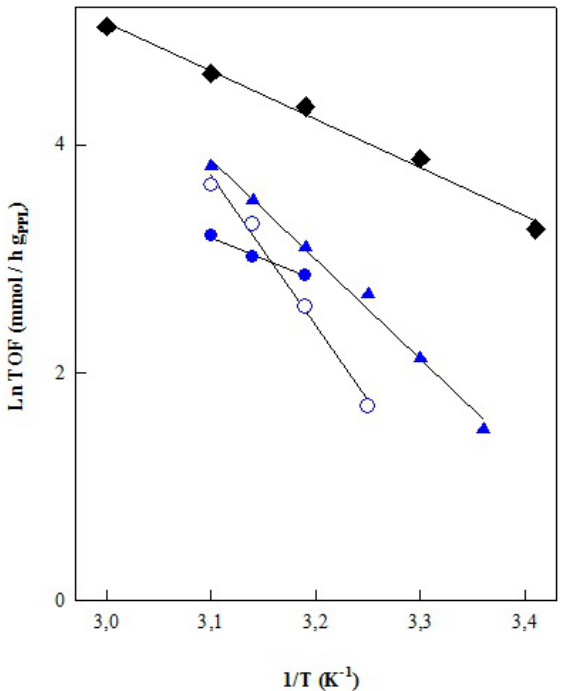
Figure 3. Arrhenius representation of enzymatic activity obtained with free and immobilized PPL, in the transesterification of used oil with 96% ethanol at pH = 12: ( ♦ ) Free PPL, EtOH; ( ● ) Immob. PPL, waste oil/96% EtOH (45/7); ( ○ ) Immob. PPL, waste oil/96% EtOH (36/6); ( ▲ ) Immob. PPL, waste oil/96% EtOH (24/4).